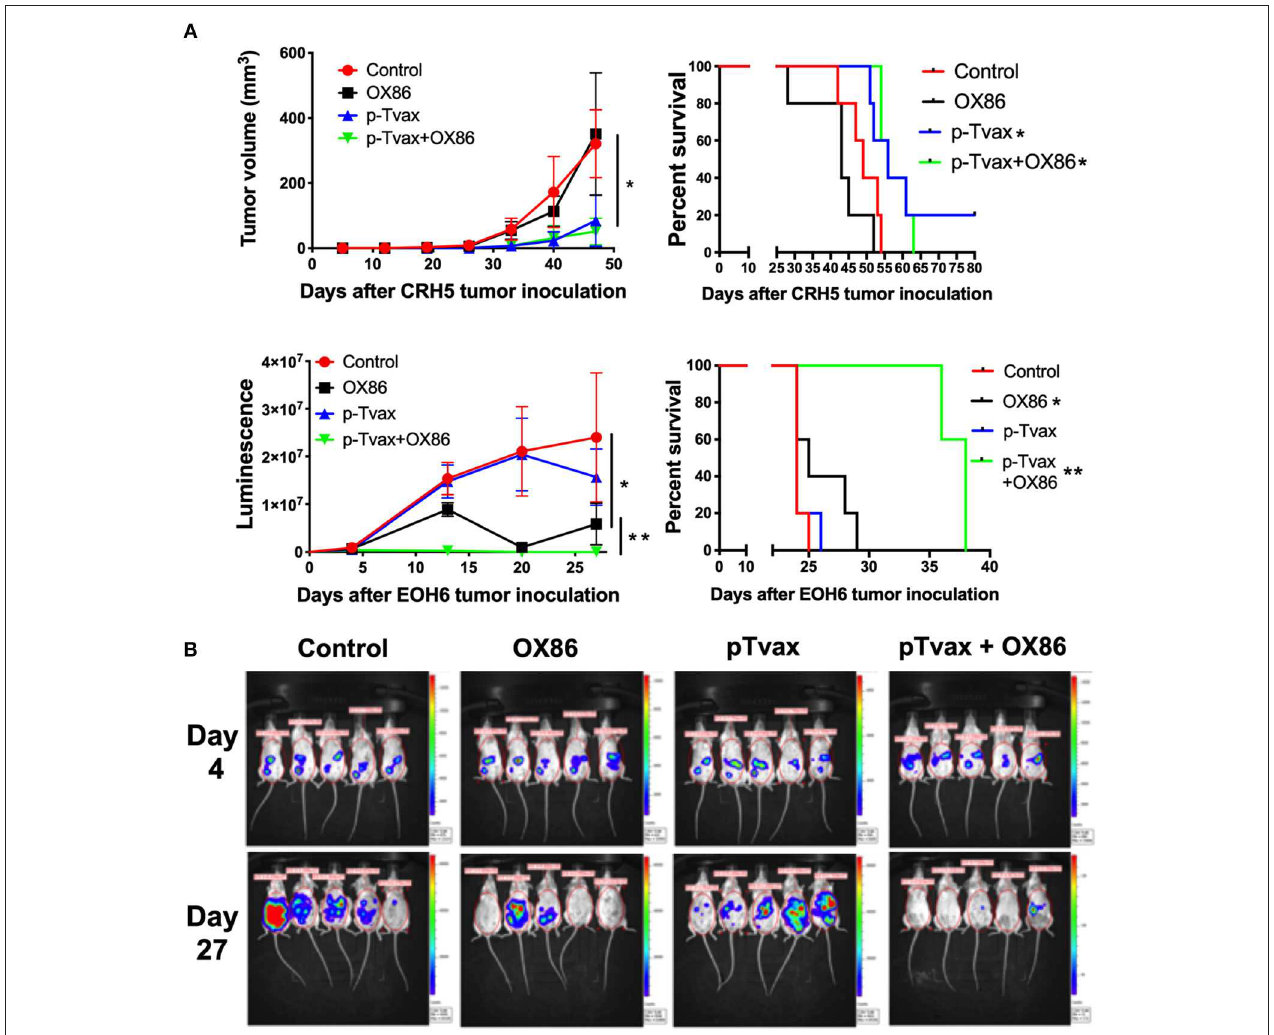
FIGURE 4 | Combination of p-Tvax vaccine and OX40 agonists delays tumor growth and improves survival in subcutaneous and intraperitoneal mouse models of MM. (A) BALB/c mice were injected s.c. with 5 × 10 4 CRH5MM cells, or i.p. with 2 × 10 5 EOH6MM cells expressing luciferase. Seven and 14 d after tumor injection, mice were vaccinated with a s.c. injection of p-Tvax peptides. CpG adjuvant was injected at days 5 and 12, while 200 µ g of OX86 was injected at day 9 and 14. Tumor volumes are showed on the left and animal survivals on the right for mice injected with CRH5 (Top) and EOH6 (Bottom). Tumor volumes were measured weekly with a caliper for s.c. tumors. I.p. MM dimensions were assessed by measuring luciferase activity with IVIS imaging following injection with luciferin substrate. Statistical significance between unvaccinated controls and single treatment (*) as well as between single and combination treatments (**), was determined by